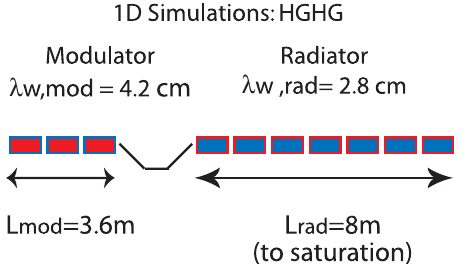
FIG. 1. (Color) Layout of the self-seeded system for the 1D simulations.